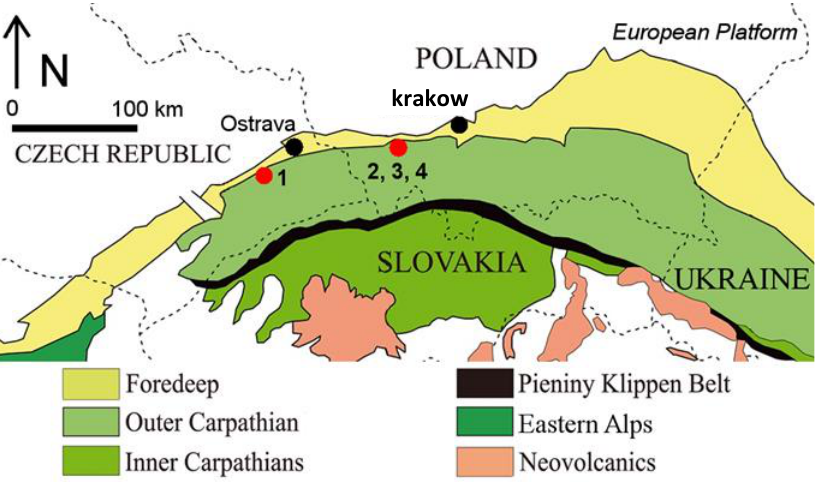
Figure 1. Geological map (simplified after [22]) showing the general location of sampling